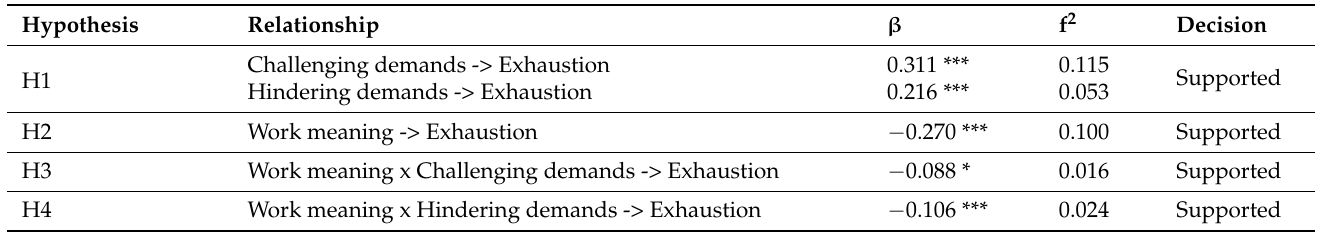
Table 5. Hypotheses